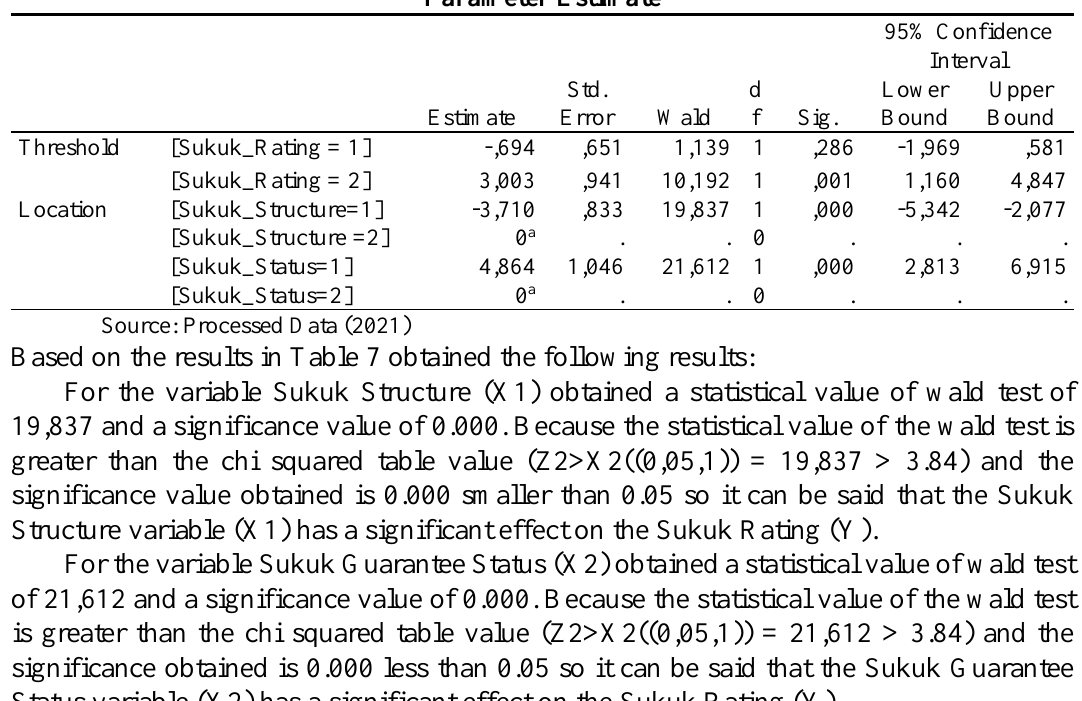
Table 7. Wald Statistical Test